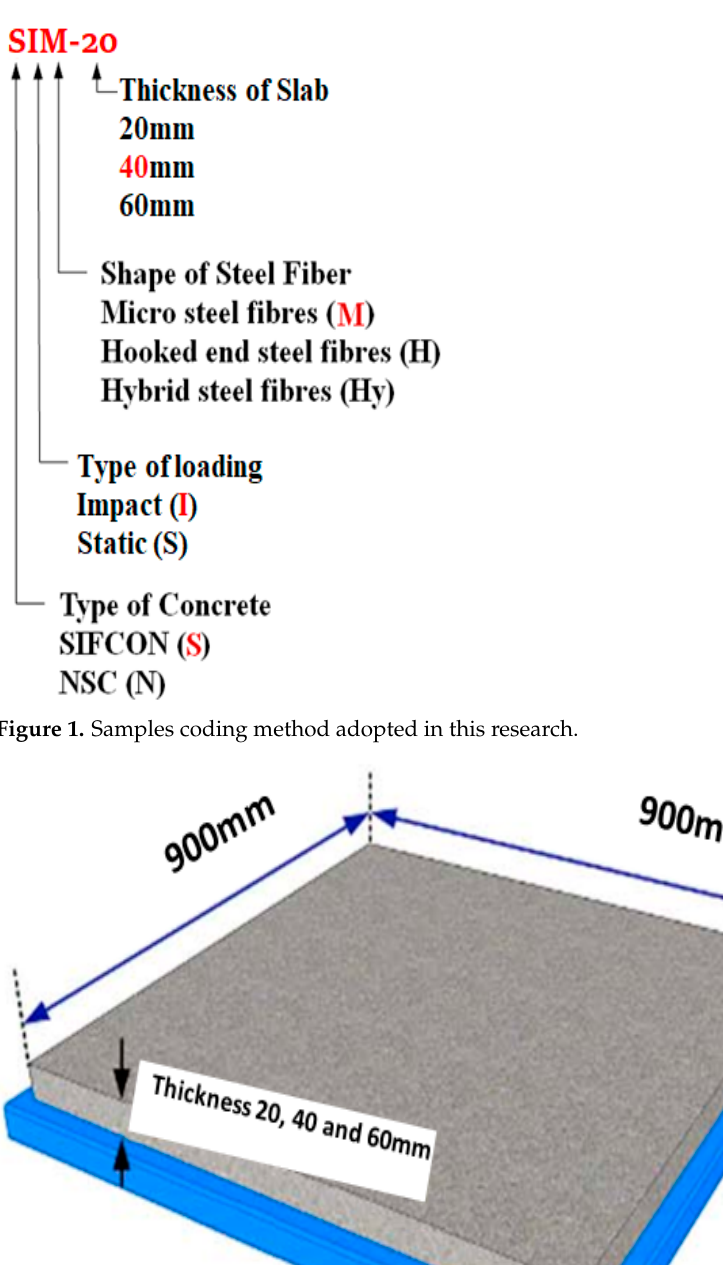
Figure 2. Details of SIFCON slab specimens.